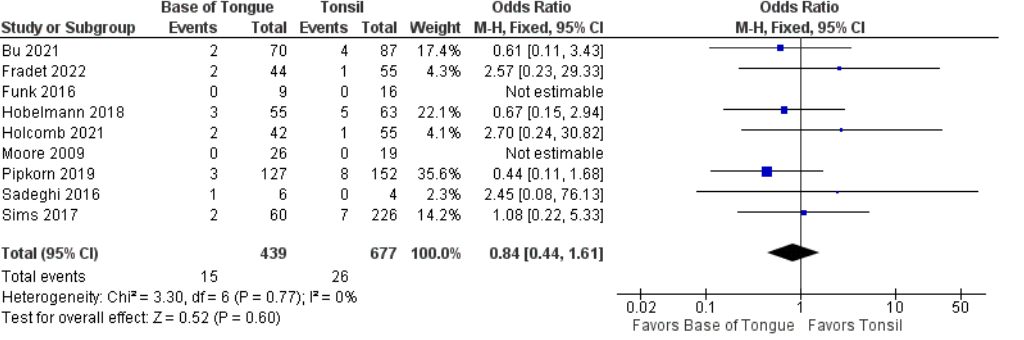
Figure 6. Comparison of metastatic recurrence between tonsillar OPSCC and base of tongue OPSCC.